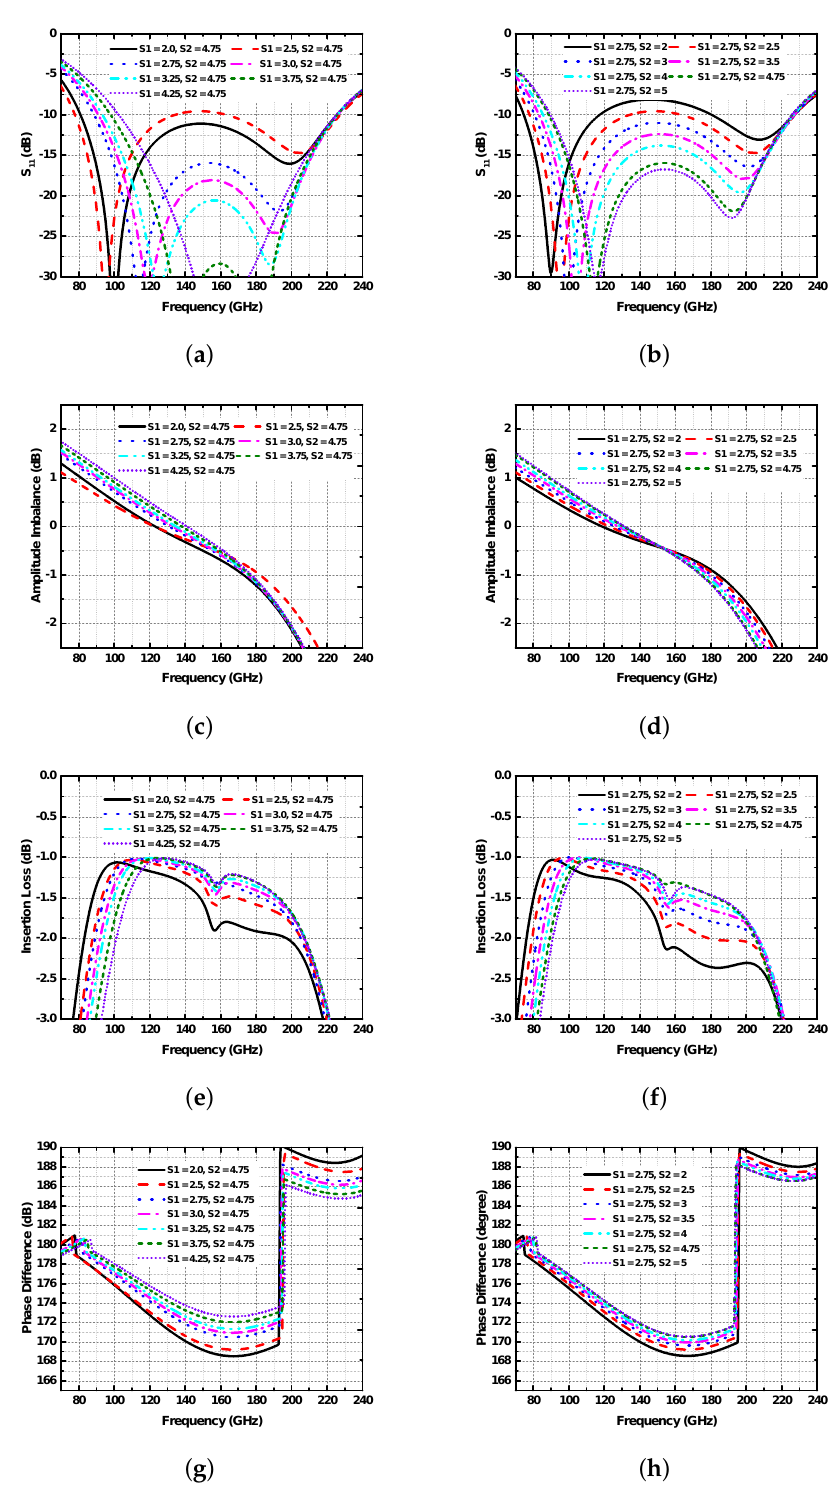
Figure 5. Simulated input reflection coefficient ( S 11 ), amplitude imbalance, and phase difference for the two gap (S1 and S2) variations with fixed widths of W1 = 5 µ m and W2 = 6.5 µ m. S 11 under S1 ( a ) and S2 ( b ) variation, amplitude imbalance under S1 ( c ) and S2 ( d ) variation, insertion loss of a single balun under S1 ( e ) and S2 ( f ) variation, and phase difference under S1 ( g ) and S2 ( h ) variation. All parameters are in µ m, while absolute values of the phase difference are shown to clearly see the phase